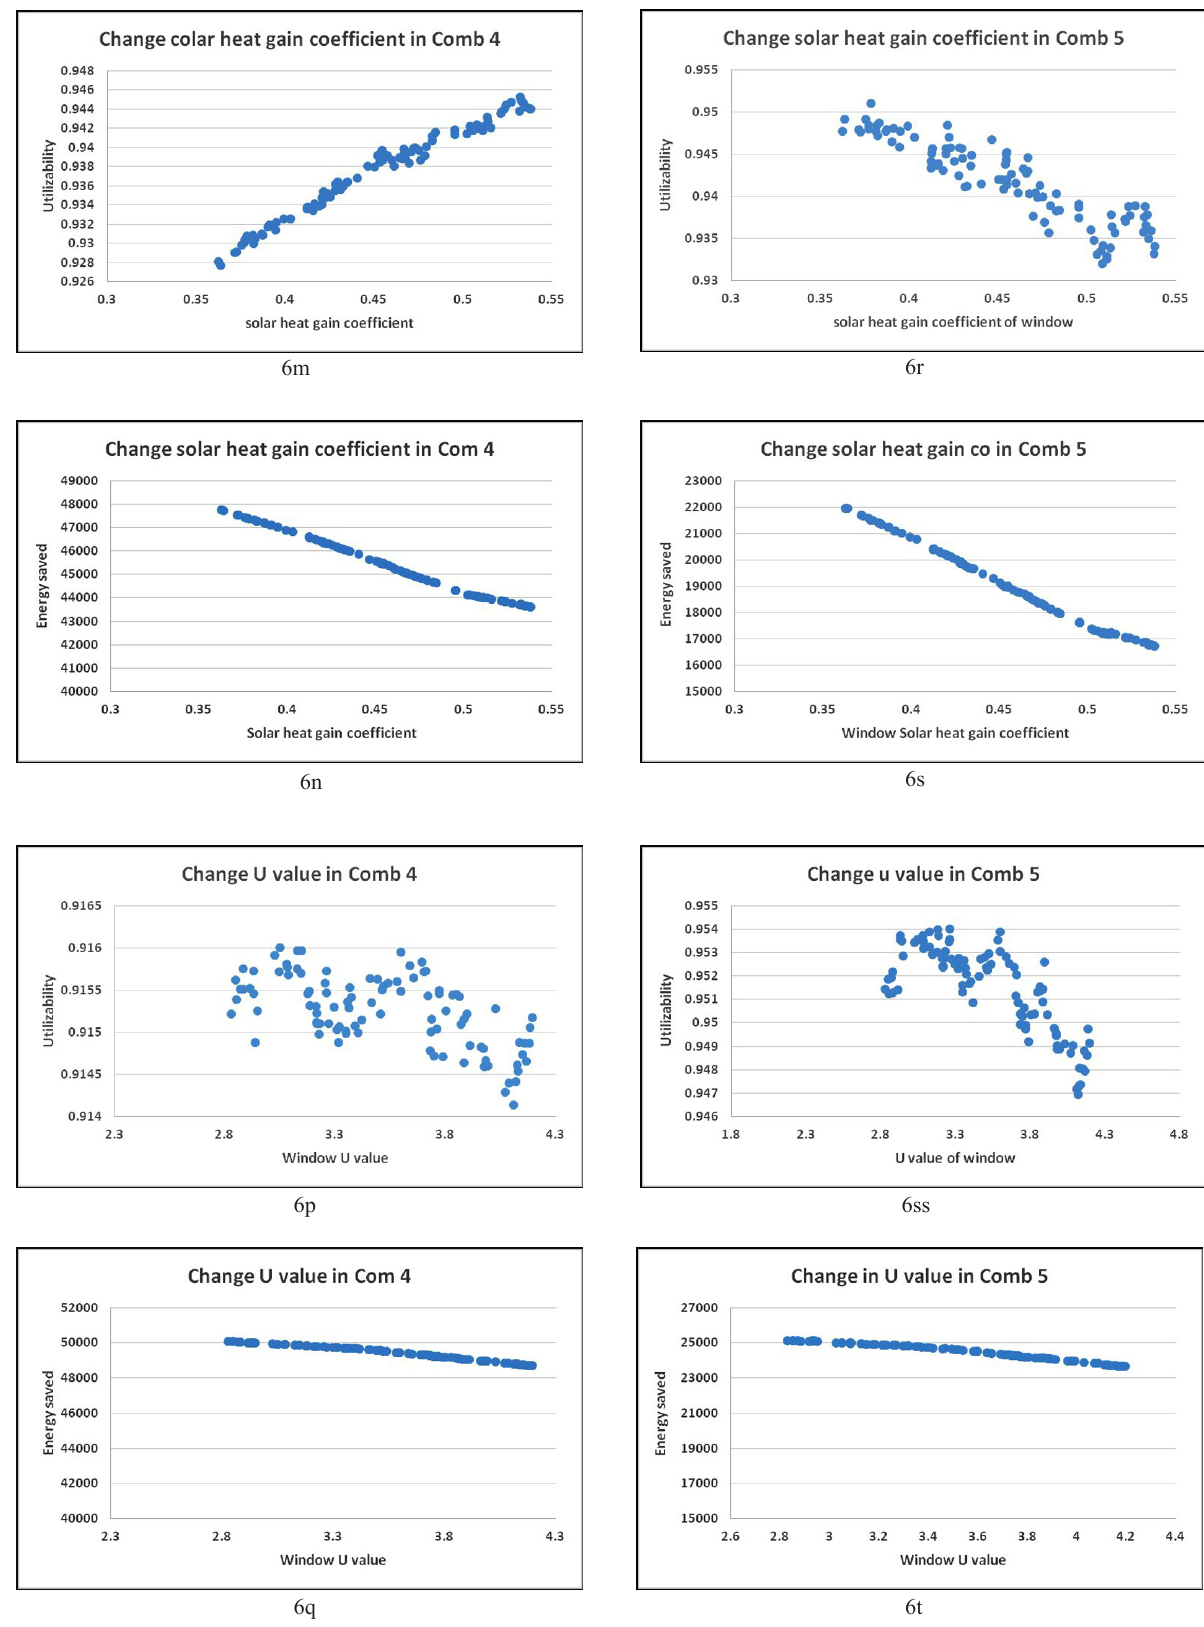
Fig. 6. Change of utilizability and energy saving with varying parameter